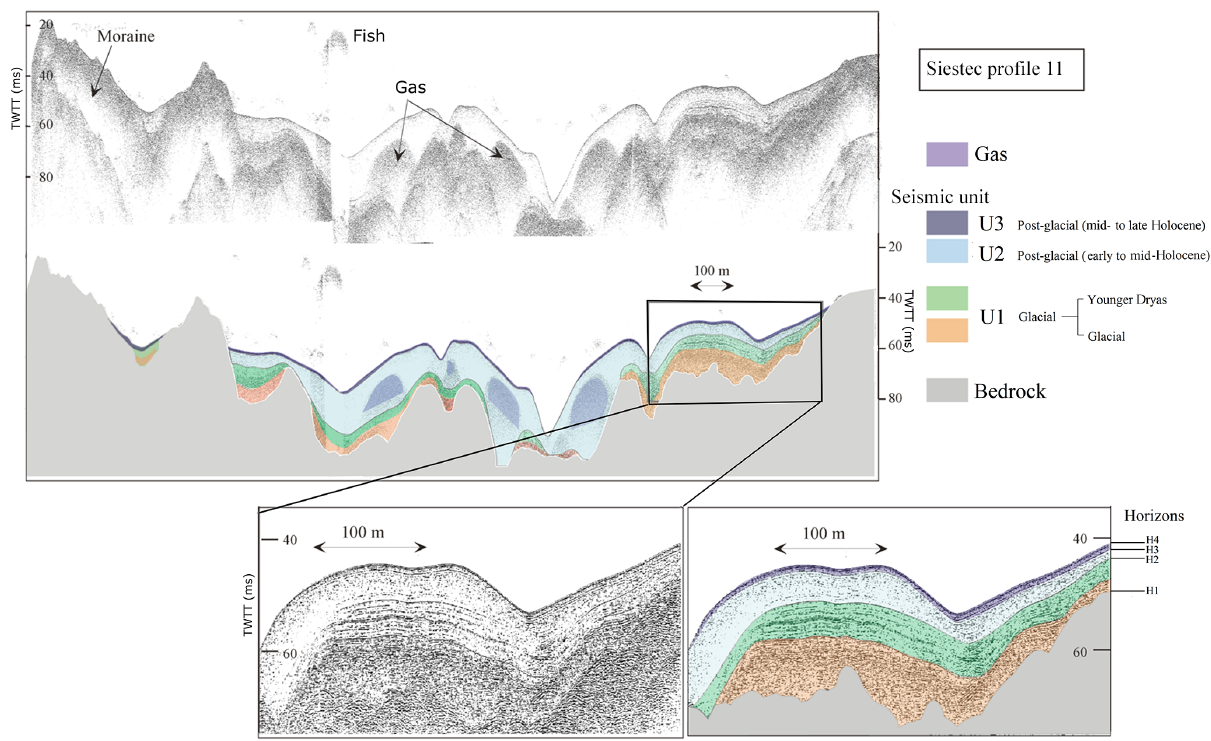
Figure 3. SIESTEC profile 11: a characteristic seismic profile displaying the four seismic horizons (H1, H2, H3 and H4) and the three seismic units (U1, U2 and U3) with depth indicated as two way travel time (TWTT), adapted from Baltzer et al.